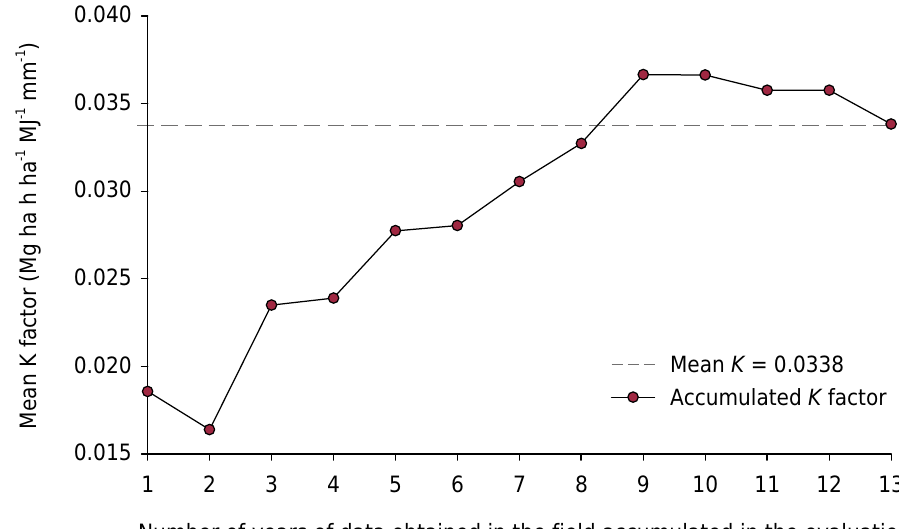
Figure 2. Variation of the K factor of the USLE according to time of evaluation, in Eldorado do Sul, RS,